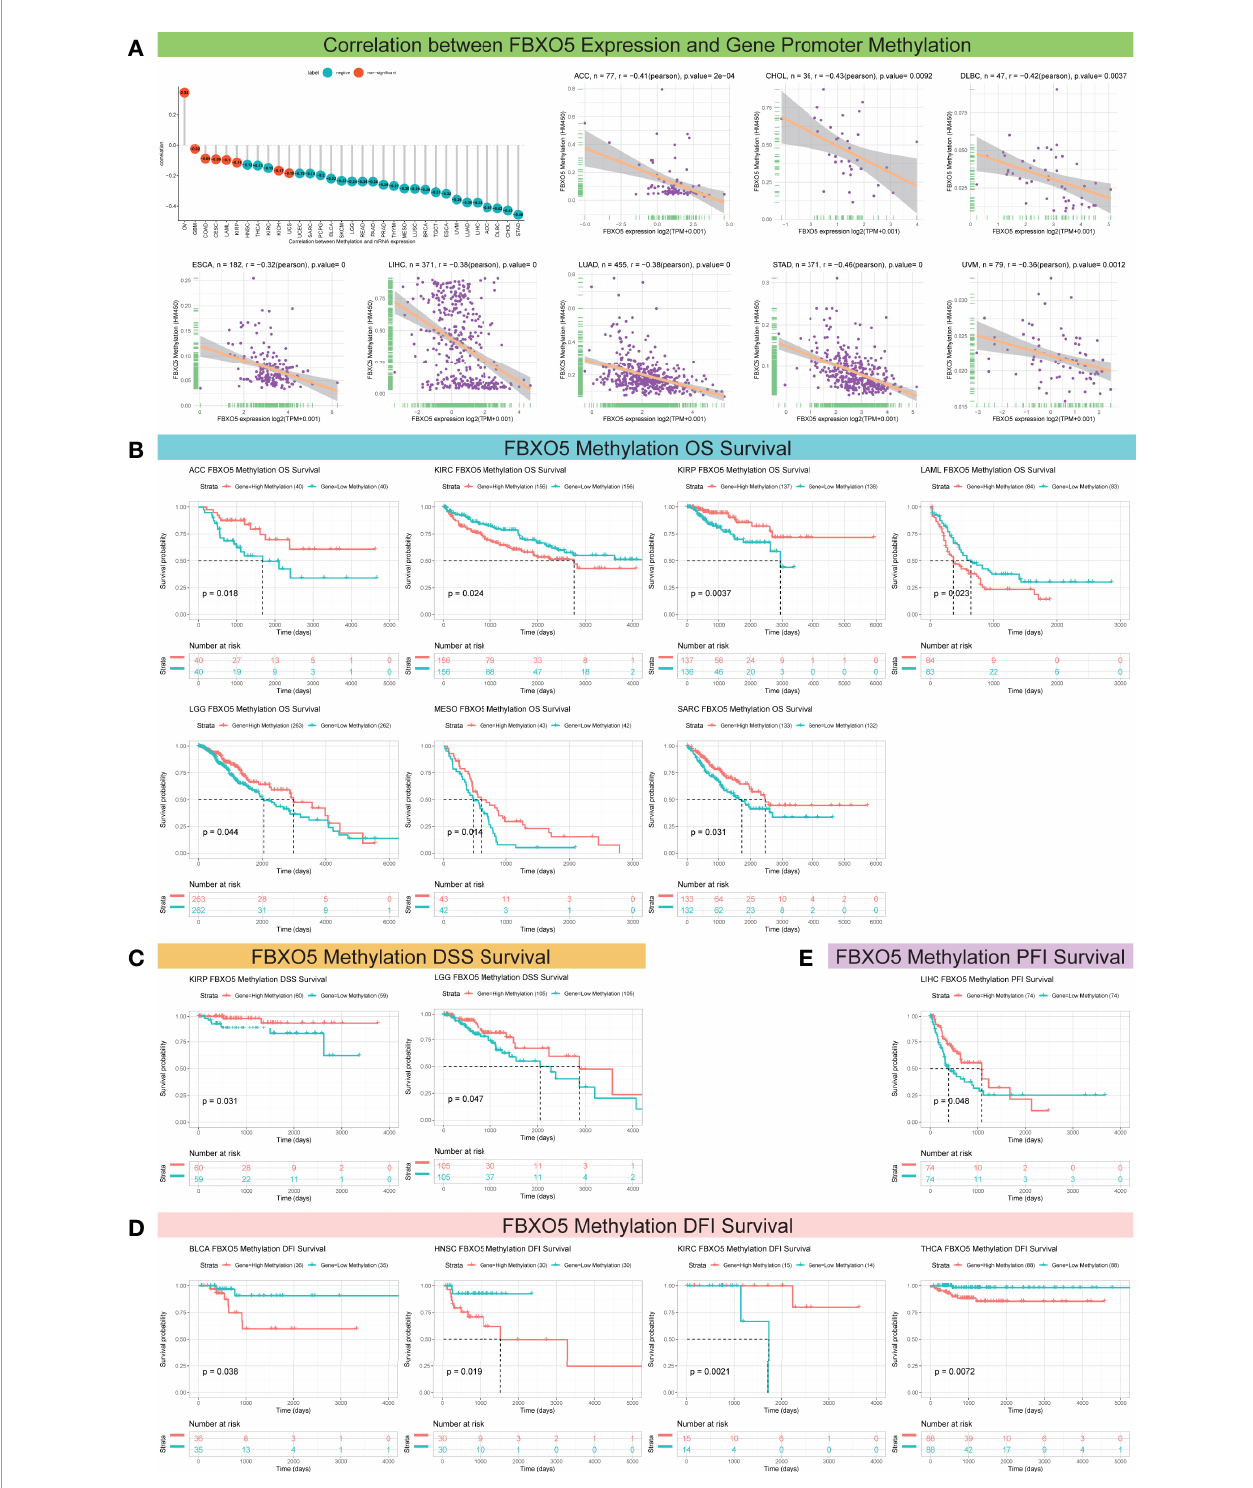
FIGURE 5 | Association between FBXO5 expression and gene promoter methylation in pan-cancer. (A) Lollipop plot and Pearson ’ s analyses depicting the correlation between FBXO5 expression and DNA methylation in the indicated tumors. (B – E) Kaplan-Meier curves illustrating the relationships between FBXO5 methylation levels with OS (B) , DSS (C) , DFI (D) , and PFI (E) in the indicated cancers,